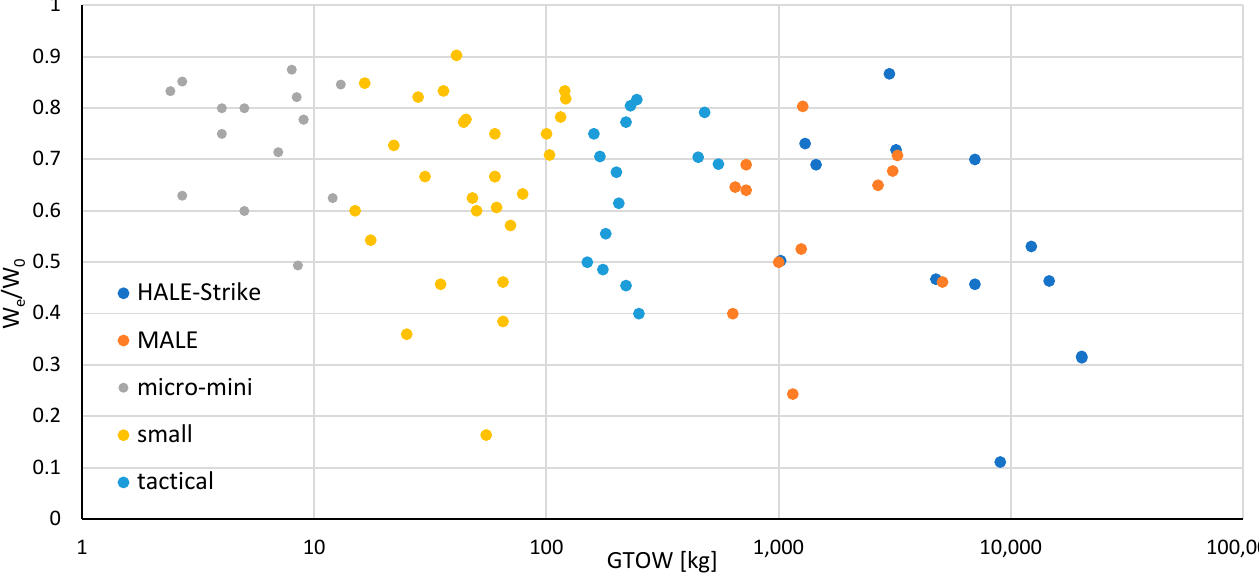
Figure 16. Empty weight divided by GTOW as a function of GTOW with respect to region of origin.